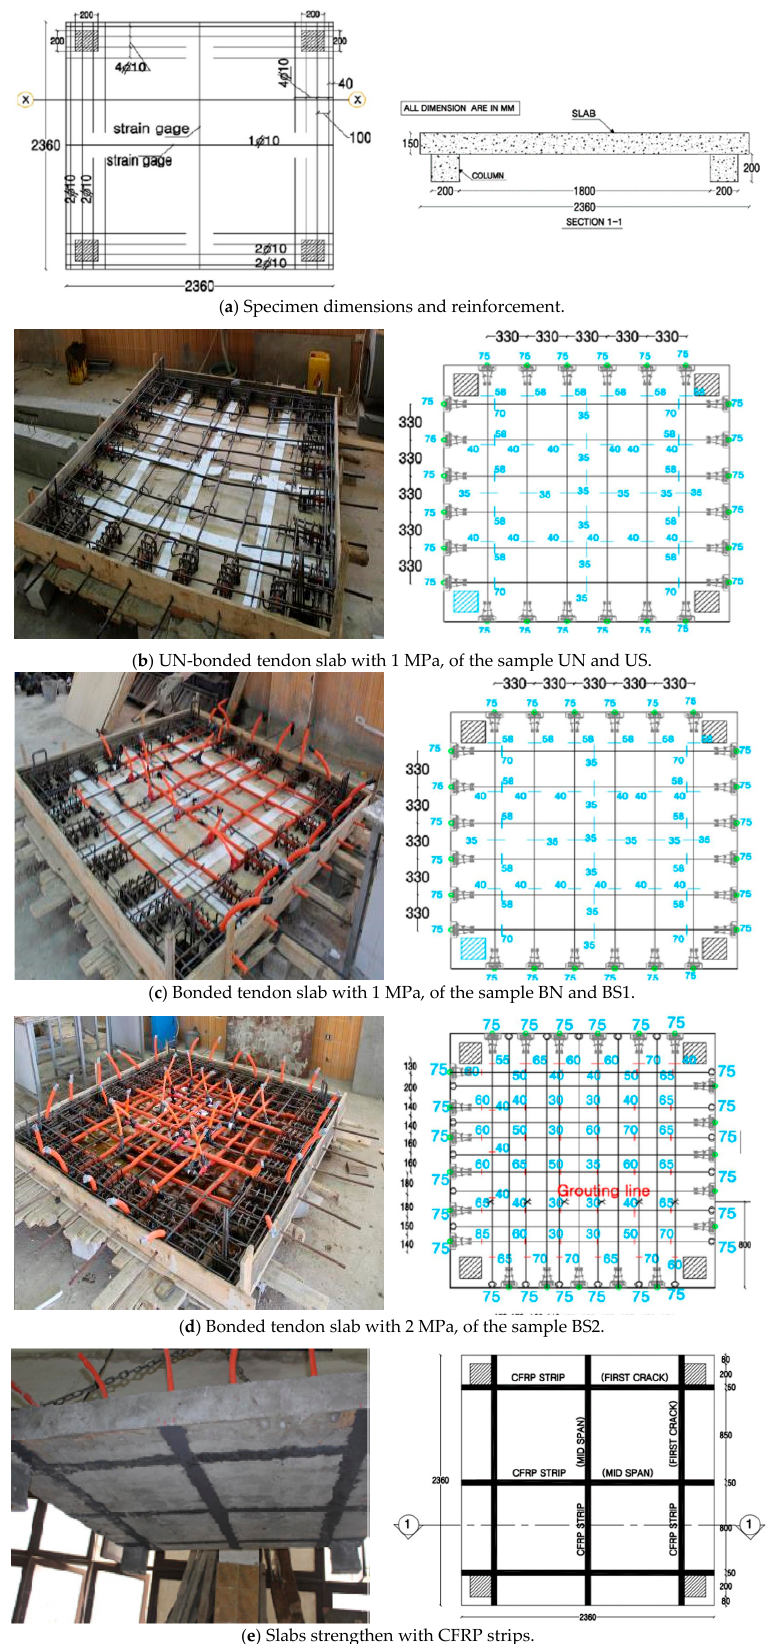
Figure 1. Typical details for all slabs [33]. Table 1. Summary of specimen’s type.